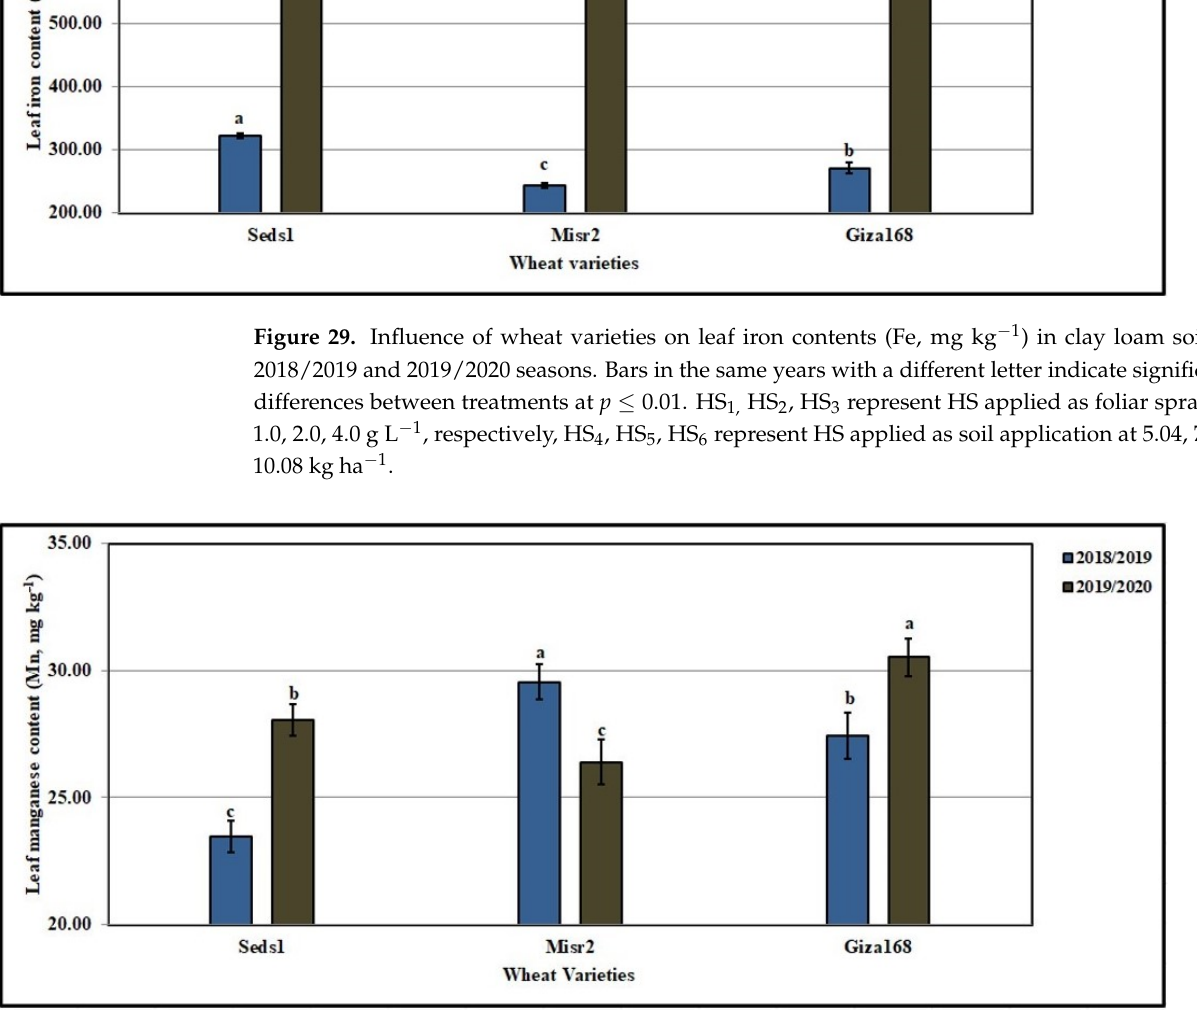
Figure 30. Influence of wheat varieties on leaf manganese contents (Mn, mg kg − 1 ) in clay loam soil in 2018/2019 and 2019/2020 seasons. Bars in the same years with a different letter indicate significant differences between treatments at p ≤ 0.01. HS 1, HS 2 , HS 3 represent HS applied as foliar spray at 1.0, 2.0, 4.0 g L − 1 , respectively, HS 4 , HS 5 , HS 6 represent HS applied as soil application at 5.04, 7.56, 10.08 kg ha − 1 .